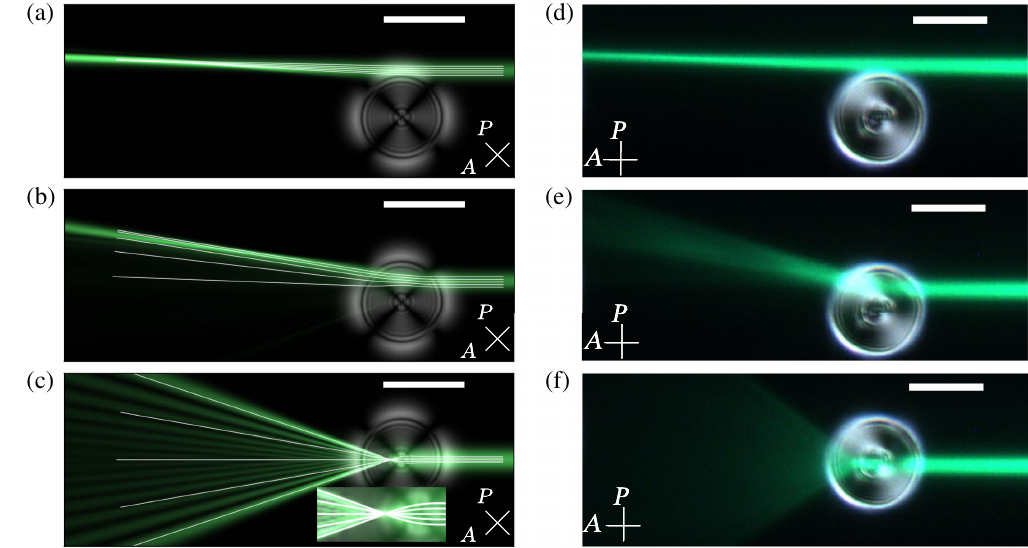
FIG. 8. A demonstration of simulated (a) – (c) and experimental (d) – (f) beam deflection and lensing from a toron at no electric field. In (a) – (c), the white lines correspond to calculated ray trajectories, while the color images are simulated as in Fig. 4 with the beam propagation method. As depicted in Figs. 7(c) and 7(d), the angle of deflection is attributable to the sign and magnitude of the deflection parameter g . Small, negative values of g produce a slightly deflected beam whose simulation is shown in (a) with experimental confirmation in (d). When g switches sharply from a very negative value to 0, defocusing and enhanced deflection occurs, as shown theoretically in (b) and experimentally in (e). By virtue of a skyrmion ’ s rotational invariance, a beam injected at the toron ’ s center experiences symmetric broadening behavior as shown theoretically in (c) and experimentally in (f). The inset in (c) shows an enlarged view of the ray trajectories near the toron ’ s center. Differences in appearance between simulated (a) – (c) and experimental (d),(e) torons mostly result from director perturbation, only near the glass plates, used to pin a toron against diffusive motion within its sample plane and from experimental illumination with a coherent white-light source. The scale bar ’ s length represents 100 μ